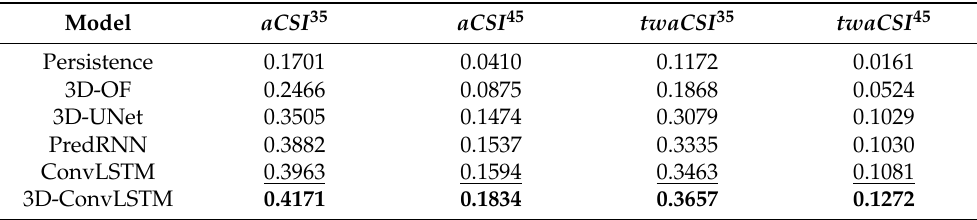
Table 6. a-Critical success index ( aCSI ) and twaCSI scores of nowcasts obtained from different models for 35 dBZ and 45 dBZ. Best and second-best scores for different metrics are marked in bold and underlined,